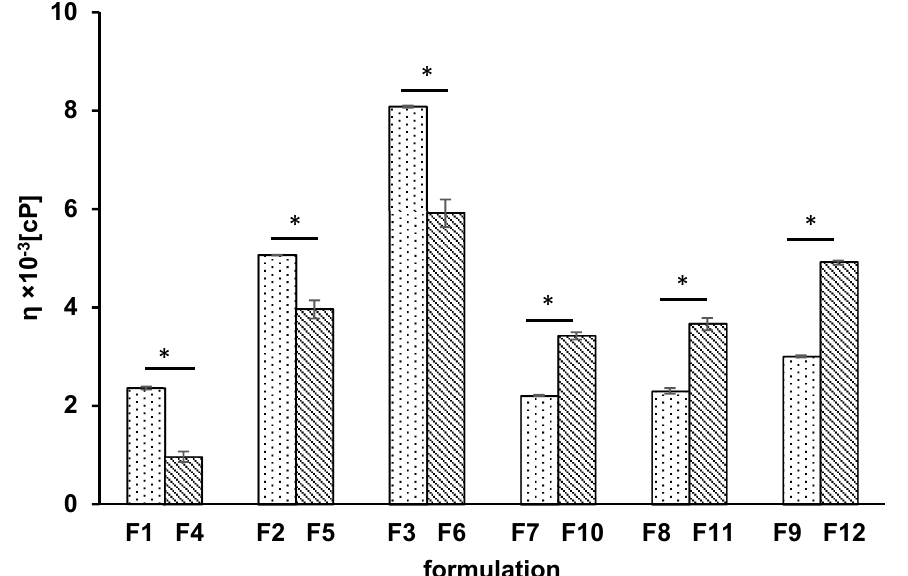
Figure 1. The viscosity of formulations F1–F12 at a temperature of 37 °C; columns with dots reflect formulations with HA, while columns with lines indicate formulations free of HA; asterisks indicate a significant difference at p ≤ 0.05 between the formulations with and without HA. Table 2. The differences between means obtained from Tukey’s test; the value of HSD was